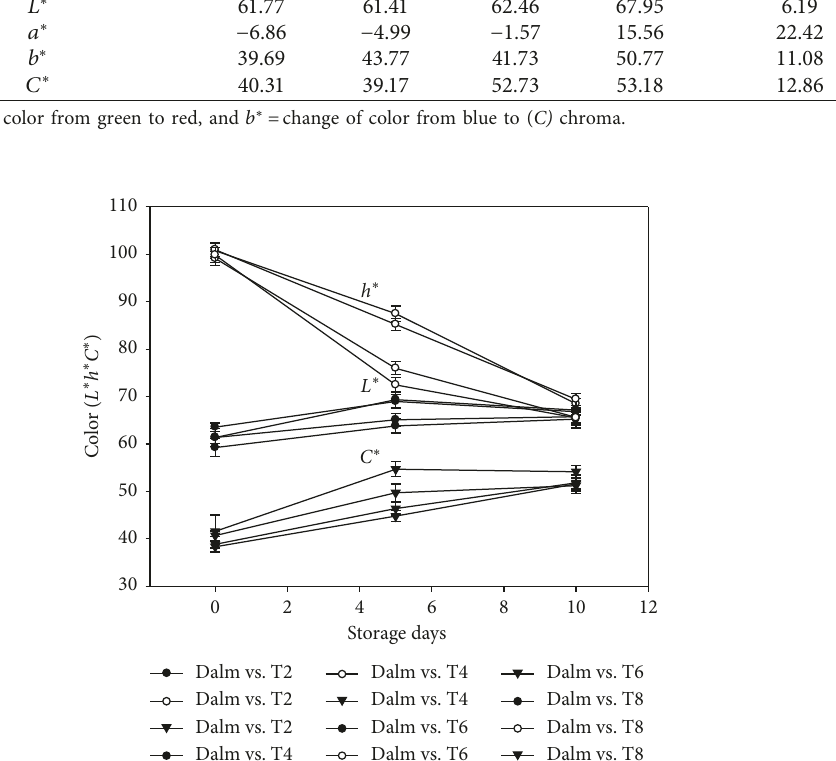
Table 2: Color evolution of fruit stored at 10 “Pear”), T3 (soursop), T5 (mango “Ataulfo”), T7 (control fruit: uncoated). Treatment